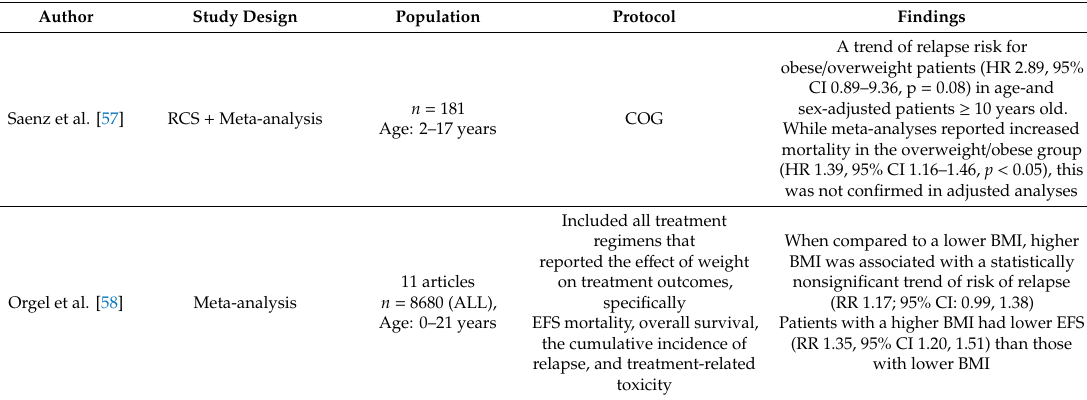
Table 3. Meta-Analyses of Relapse Risk with Obesity in ALL Patients. Protocol